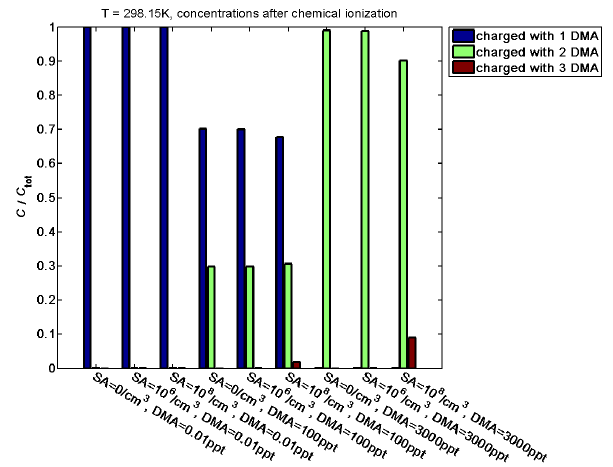
Figure 4. Relative concentrations after ionization grouped by the amount of DMA molecules in the cluster.